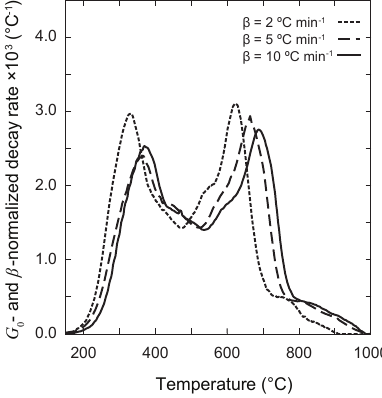
Figure 3. Testing the ramp-rate effect. Measured thermograms are shown for Narayani POC analyzed using multiple ramp rates ( β ). Decay rates have been normalized by G 0 and β in order to properly compare y -axis values between each